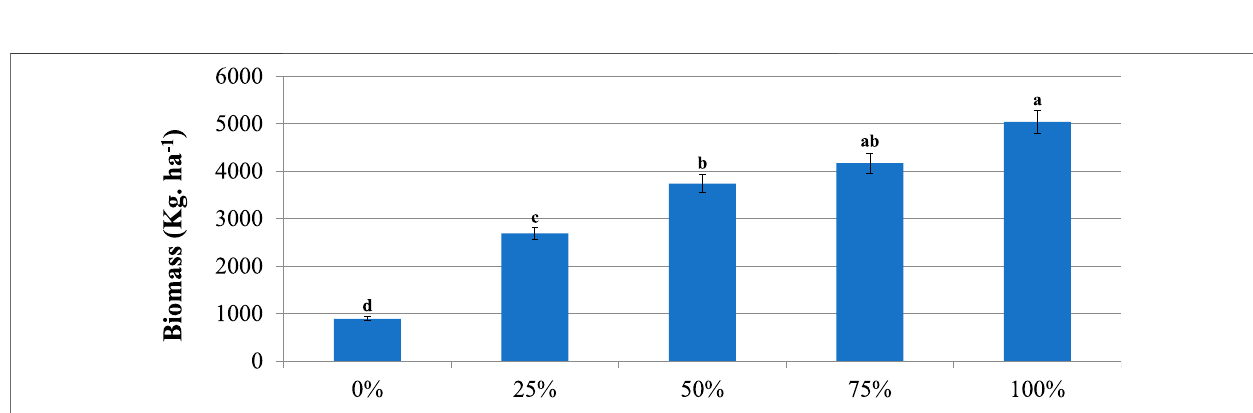
Frontiers in Environmental Science |